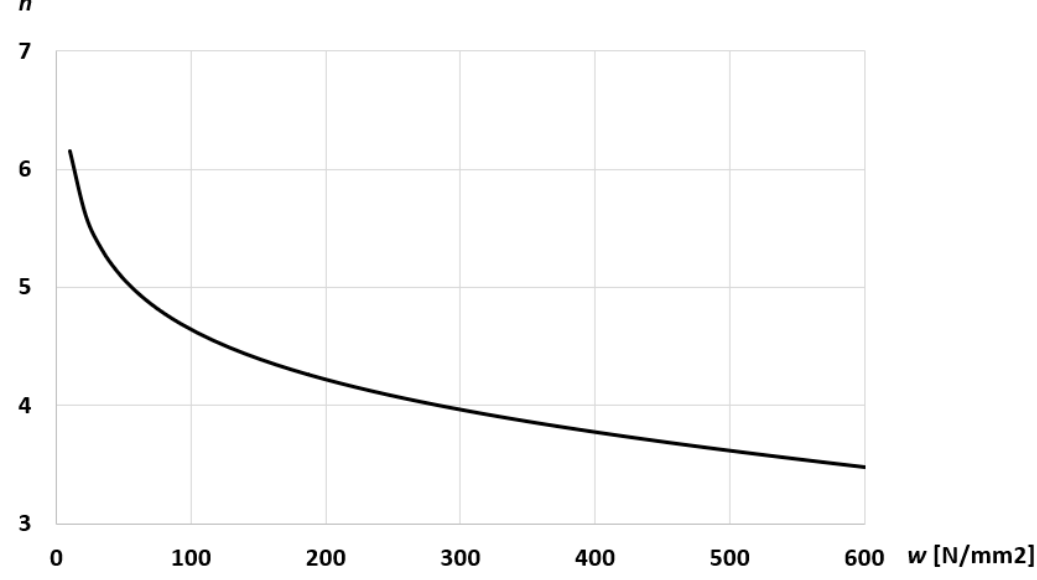
Figure 10. Dependence of n ‐ value on the plastic work.